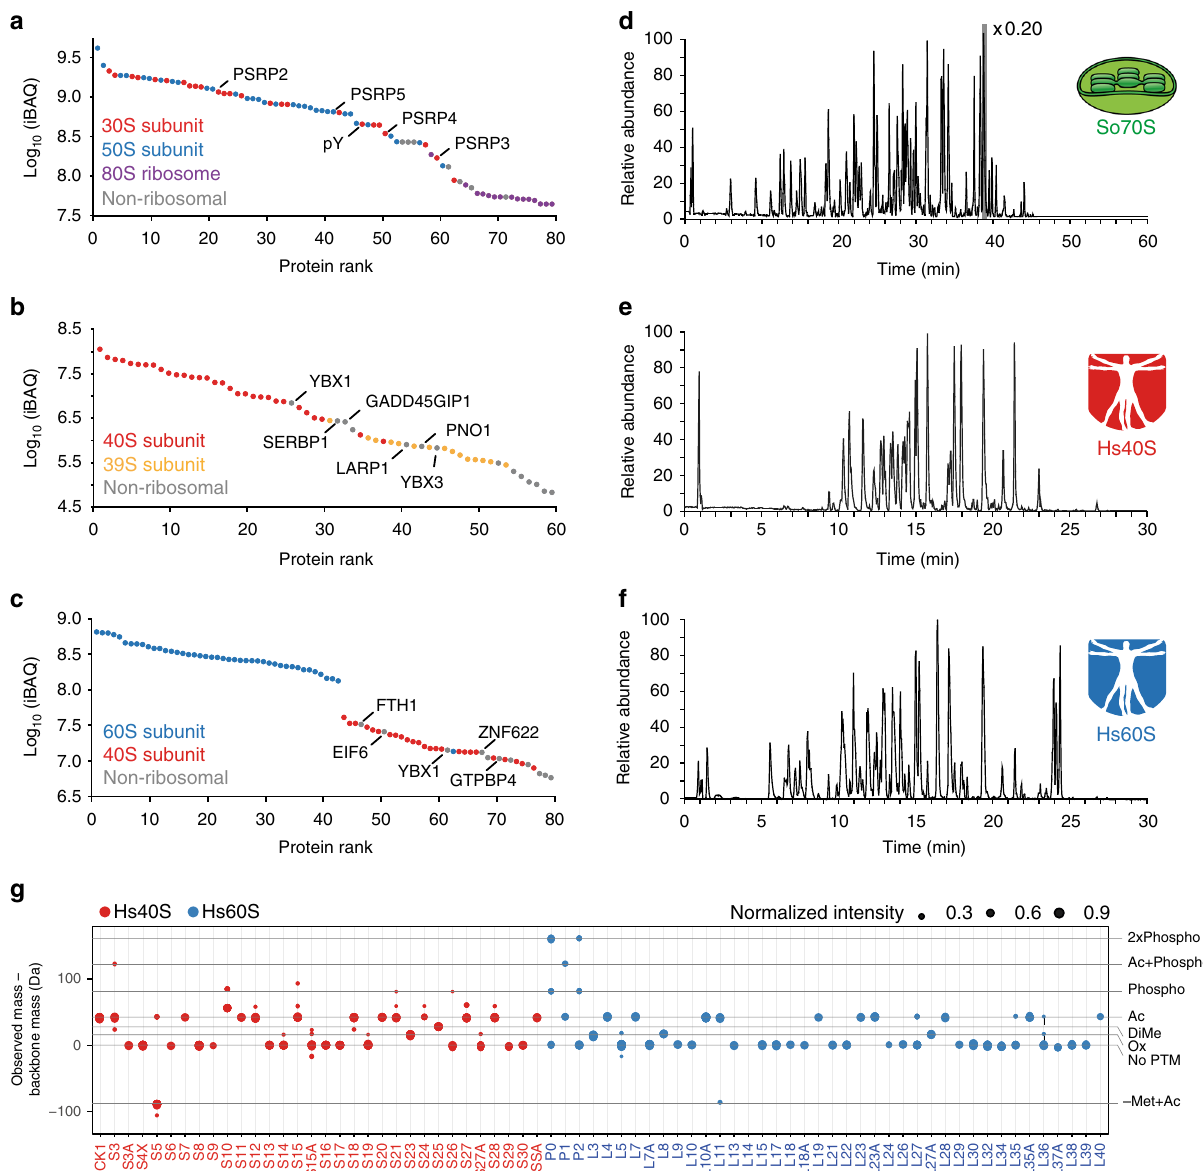
Fig. 2 Dissecting ribosomal particles from different organisms and organelles by bottom-up and top-down LC-MS/MS analyses. a – c Relative quanti fi cation of both ribosomal and non-ribosomal proteins present in the preparations of So70S, Hs40S, and Hs60S ribosomal particles, respectively. Protein abundance was estimated by using the intensity-based absolute quanti fi cation (iBAQ) values of each identi fi ed protein. d – f Top-down LC-MS/MS base peak chromatograms of all proteins in the So70S, Hs40S, and Hs60S ribosomal particles, respectively. Top-down LC-MS/MS analysis allows for identi fi cation of both ribosomal and non-ribosomal proteins and their distinct proteoforms. g Relative abundance distributions of proteoforms detected in ribosomal proteins of the 40S and 60S subunit identi fi ed by database searching. Each dot represents a proteoform of the gene products listed on the x -axis with increasing size representing increasing relative abundance. The position of the dots along the y -axis shows the deviation of measured mass of the proteoform from the mass calculated from the amino acid sequence. Several commonly occurring post-translational modi fi cations (e.g., acetylation, phosphorylation) are annotated with their corresponding mass shift. The data point for L14 is missing since the observed mass shifts introduced by a varying number of inserted alanine repeats is outside the scale of the plot (namely: + 213 and + 355 Da). To stay consistent, we adopted the ribosomal protein names from Uniprot entries. The pictograms of the Vitruvian man were prepared based on an image that was obtained under a CC0 license